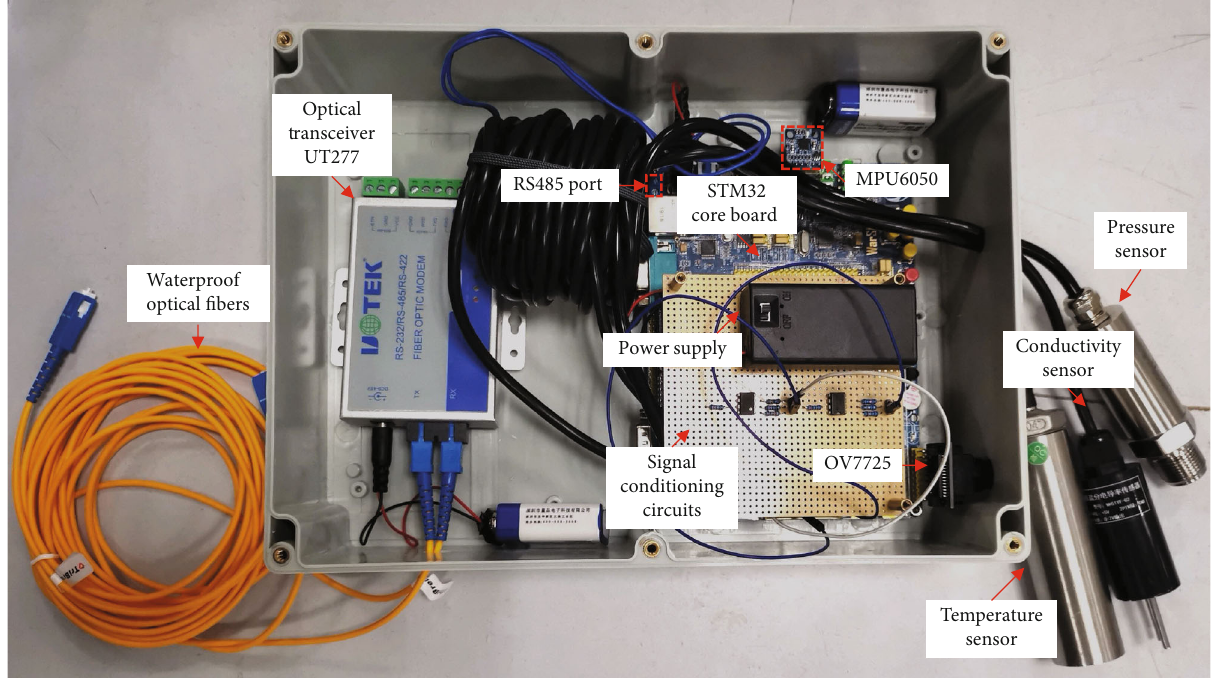
Figure 5: Packaged